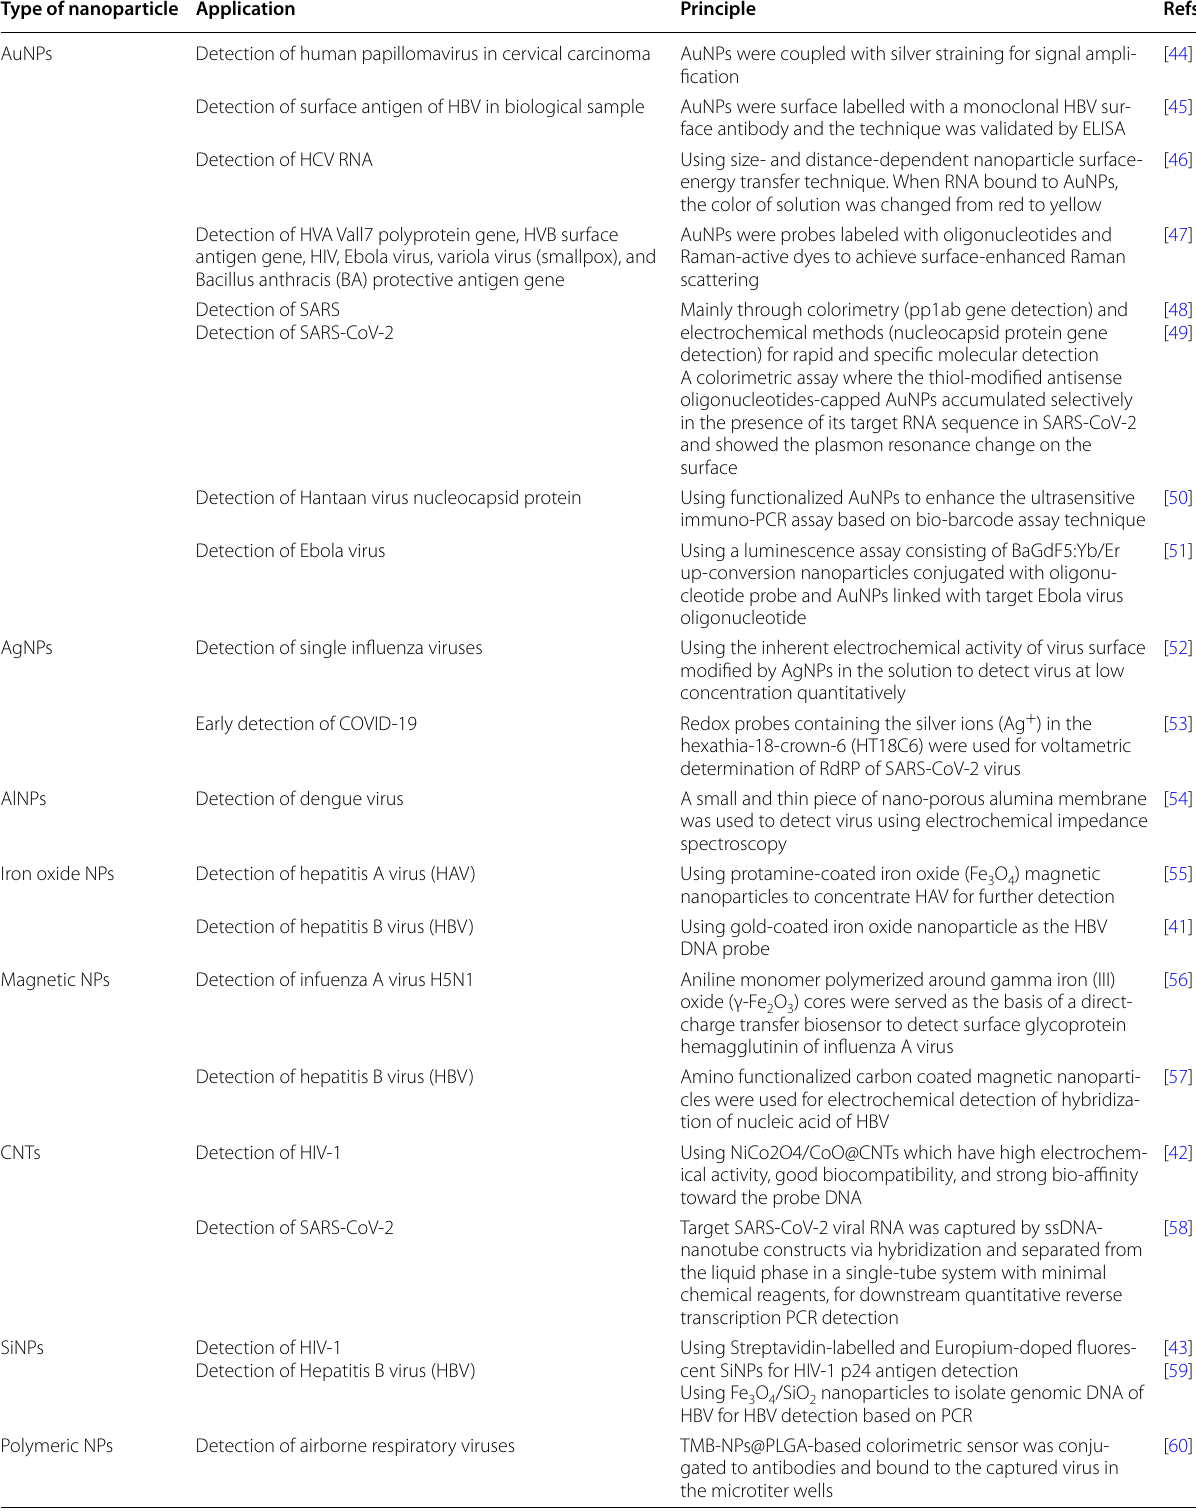
Table 2 Various nanoparticles used for viral detection Type of nanoparticle